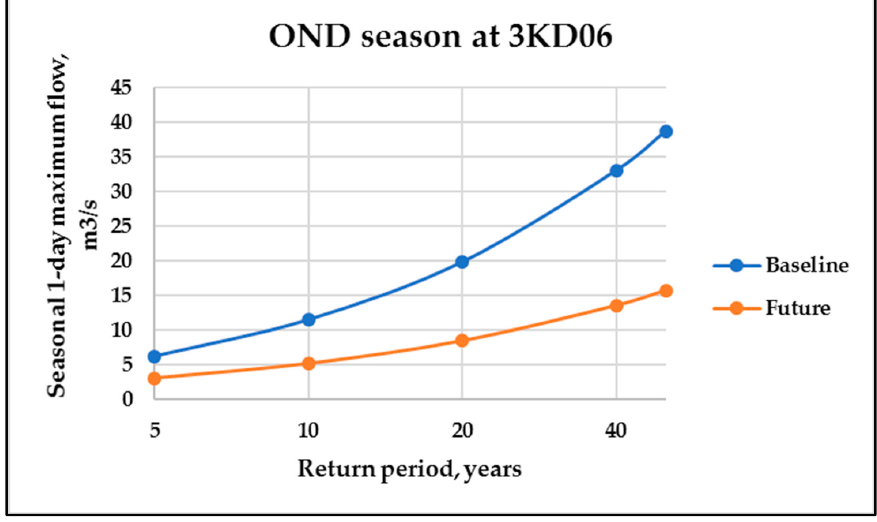
Figure 13. Return periods comparison of the maximum one day flow for OND